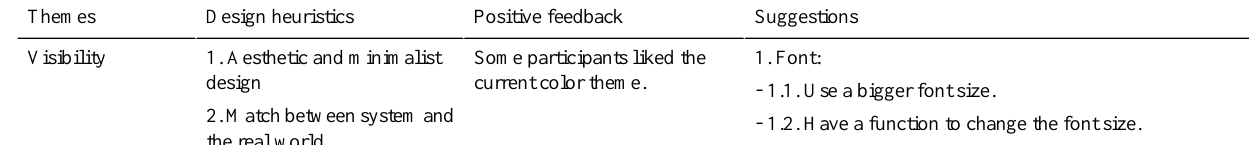
Table 2. Feedback for overall app design.